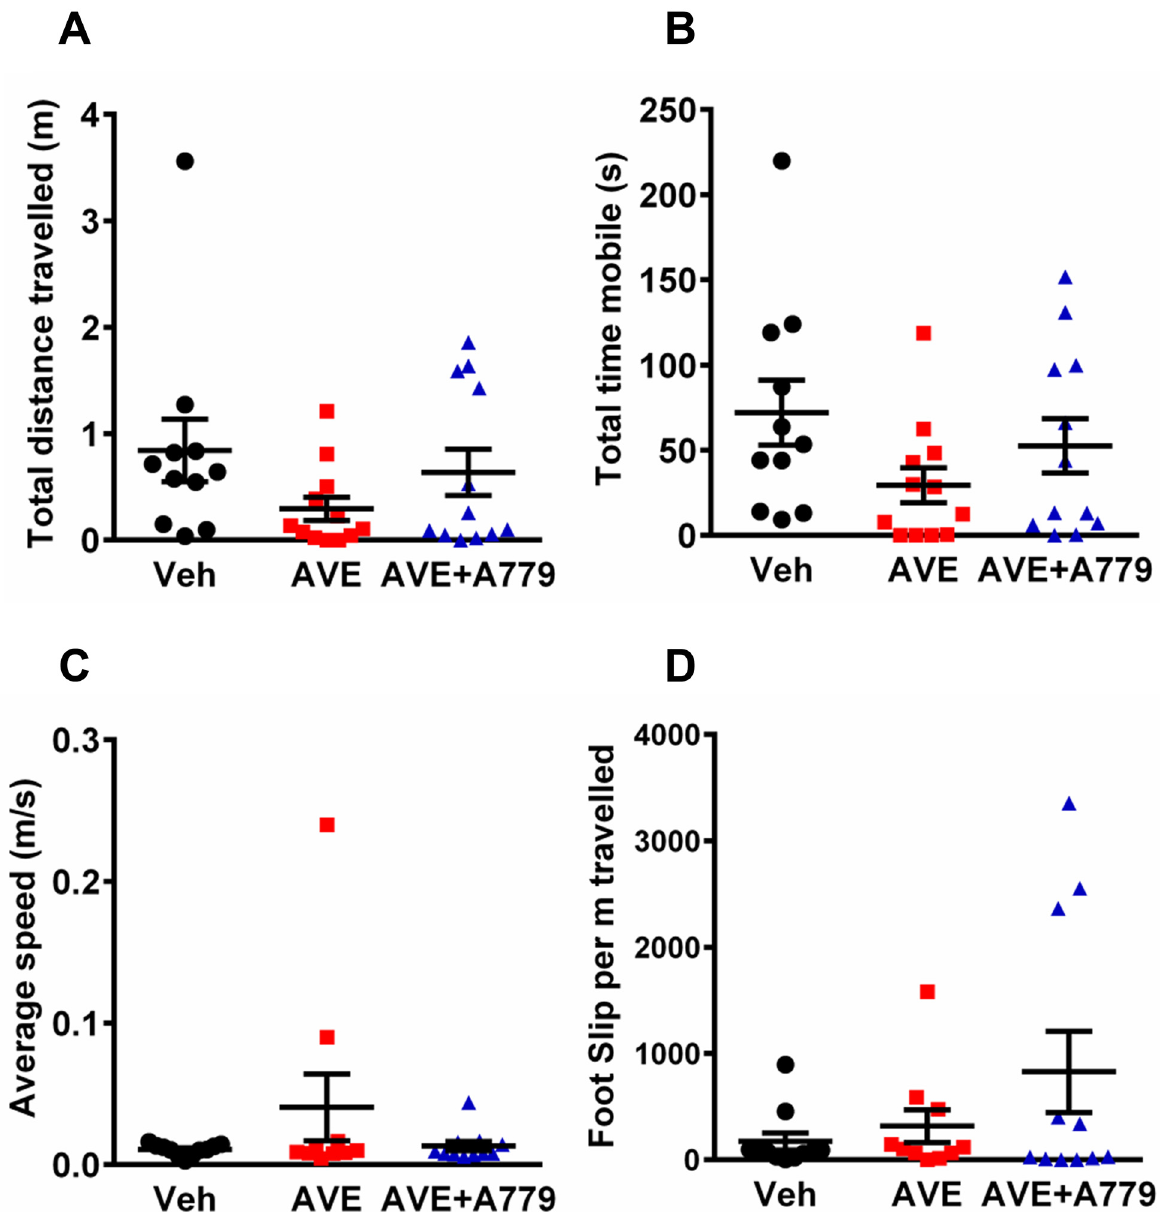
Fig 3. Locomotor activity and motor coordination test. Data for (A) total distance travelled, (B) total time mobile, (C) average speed while mobile and (D) foot slips per m travelled. Data are presented as mean ± S.E.M (n = 11 –